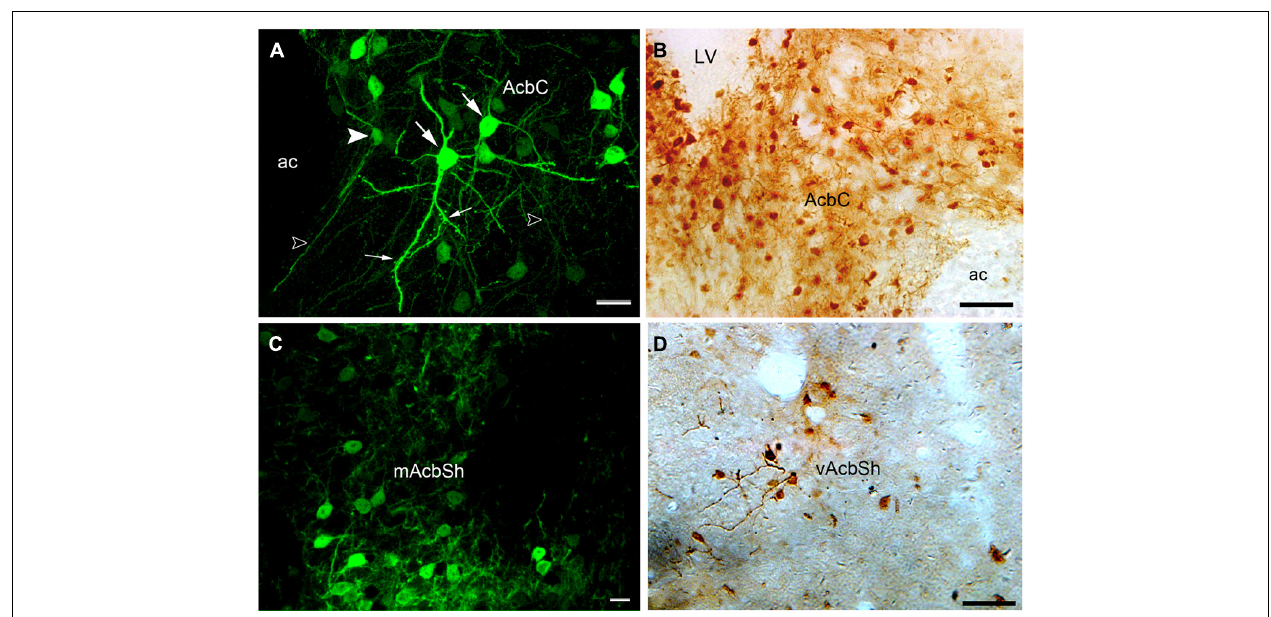
FIGURE 3 | Images showing hrGFP-IR-positive neurons in theAcb of the adenosineA 2A R Cre mouse. (A,B) The hrGFP-IR neurons in the core visualized by fluorescent and ABC techniques. Most of the perikarya in the core were observed as multipolar (large arrows) and bipolar (arrowhead) neurons.The dendrites extending from the perikarya were thick, and some of them had punctuate spines (small arrows).The axons were thin, straight